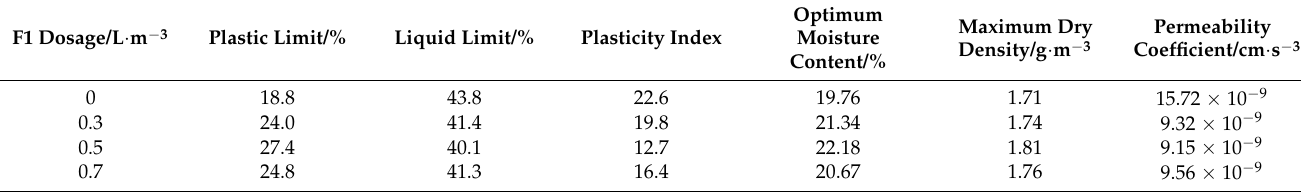
Table 2. Physical parameters of solidified red clay with different F1